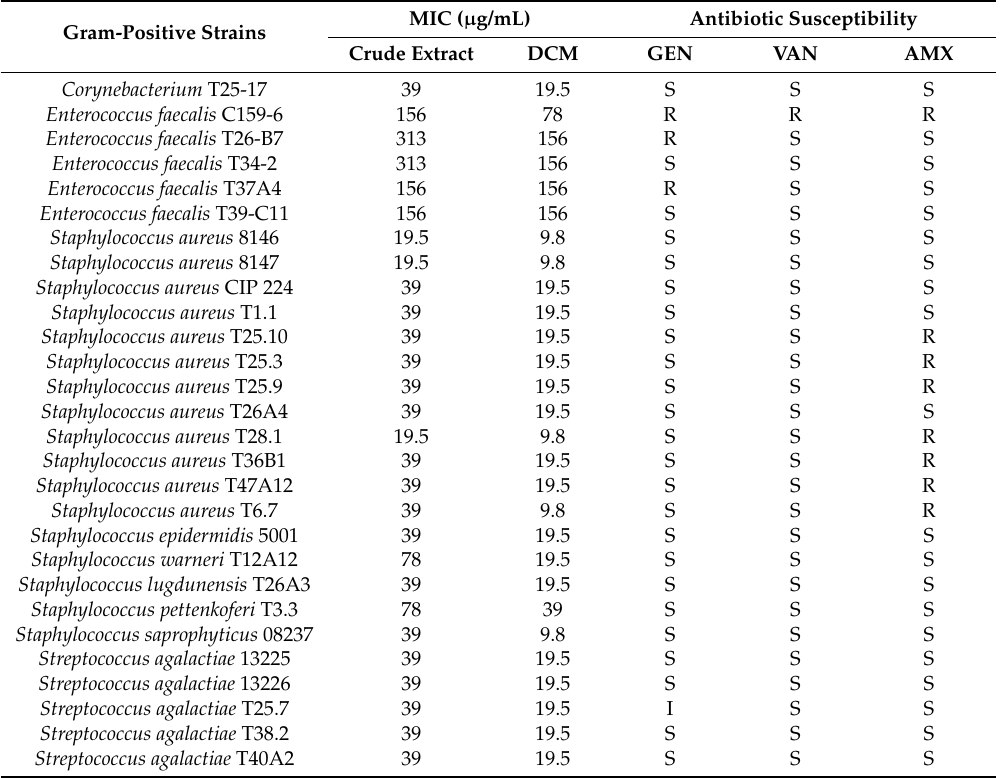
Table 2. MIC (in µ g/mL) of the crude extract and the dichloromethane (DCM) sub-extract of cones against Gram-positive strains with their corresponding antibiotic susceptibility (S: susceptible, I: intermediate, R: